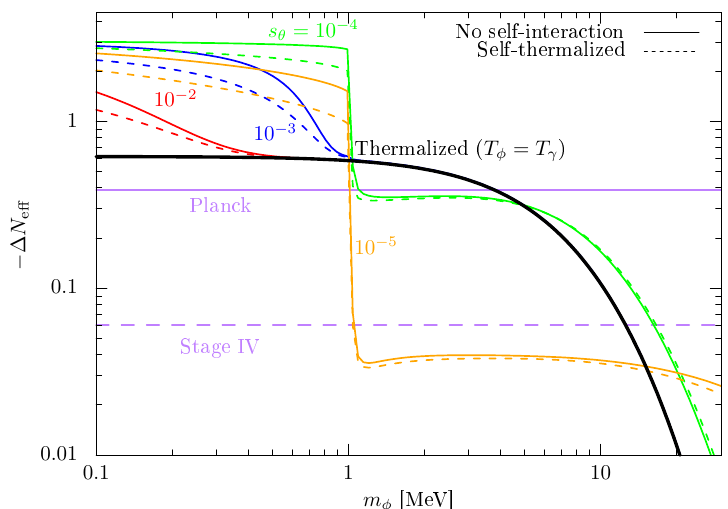
Figure 12. The − ∆ N eff = − ( N φ − N SM ) as a function of m φ . Here we take T R = 30 MeV. The eff eff purple solid line denotes the CMB constraint of N eff > 2 . 66 [64] by the Planck experiment and the purple dashed line indicates the 2 σ sensitivity, | ∆ N eff | = 0 . 06 , of the CMB stage-IV experiments